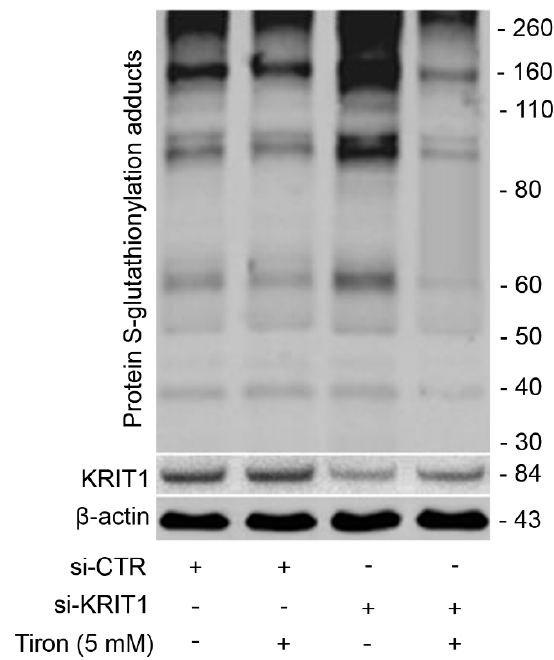
Figure 7. Redox-dependent changes in PSSG occur in human brain microvascular endothelial cells upon KRIT1 knockdown. Human brain microvascular endothelial cells (hBMEC) grown under standard conditions were transfected with either KRIT1-targeting siRNA (si-KRIT1) or a scrambled control (si-CTR). Cells were then either left untreated or treated with Tiron, lysed, and analyzed by Western blotting under nonreducing conditions with an anti-GSH antibody to detect protein S -glutathionylation adducts, and then compared with KRIT1 protein expression levels. β -actin was used as internal loading control for Western blot normalization. Results are representative of three separate experiments. Notice that KRIT1 knockdown in human brain microvascular endothelial cells leads to a significant increase in the levels of protein S -glutathionylation adducts, which are significantly reverted by cell treatment with the ROS scavenger Tiron.